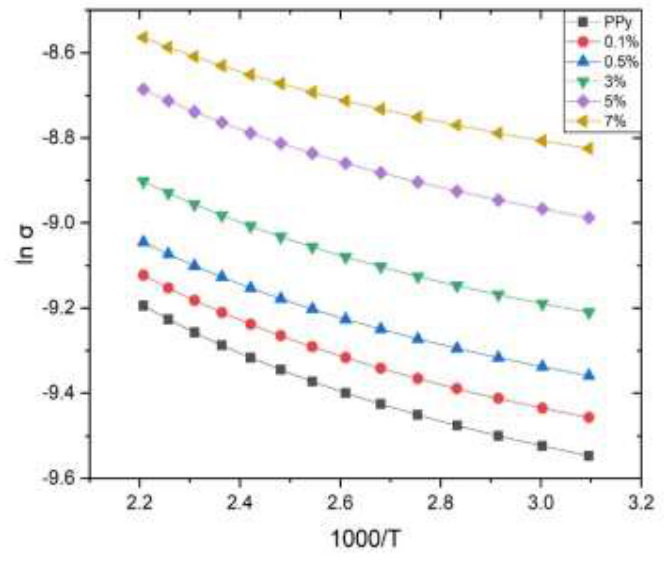
Fig.4: Variation of DC conductivity with temperature of PPy and PPy-Ag nanocomposite.